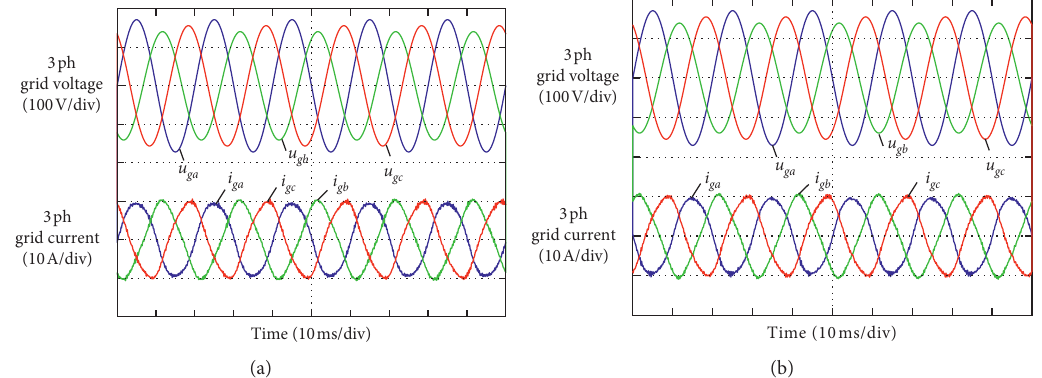
Figure 13: Simulation results of PCS connected to a nonideal grid. (a) Three-phase grid voltage and current in battery-discharging condition. (b) Three-phase grid voltage and current in battery-charging condition.